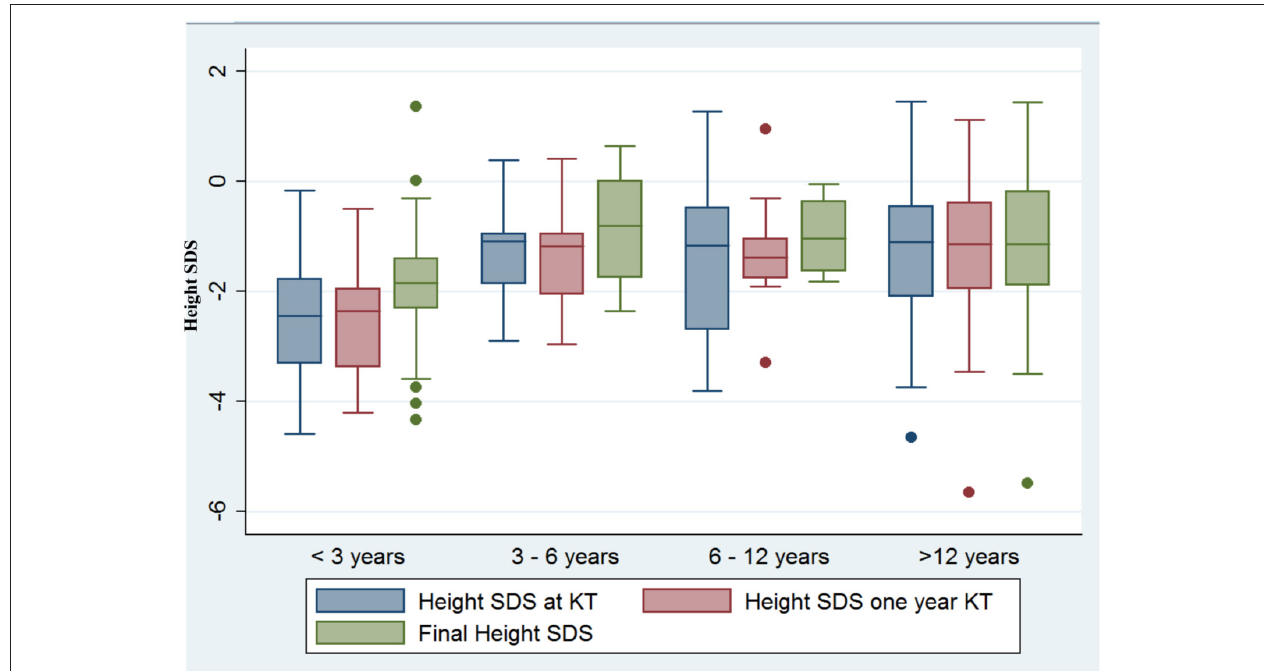
FIGURE 1 | Linear growth after KT according to patient age at the day of transplant. Children younger than 3 years old exhibited the most significant growth retardation at baseline and the greatest linear growth over time ( − 2.29 SDS height vs. − 1.82 SDS height, p = 0.02), and also children from 3 to 6 years of age improved significantly (SDS height − 1.26 to − 0.74, p = 0.04), whereas catch-up was not observed in older patients.